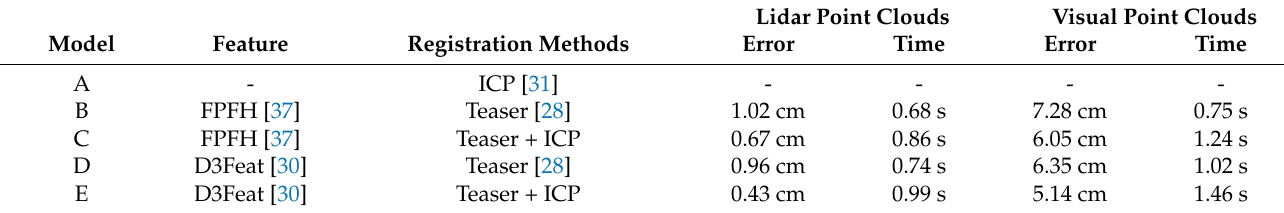
Table 9. Accuracy evaluations of registration.